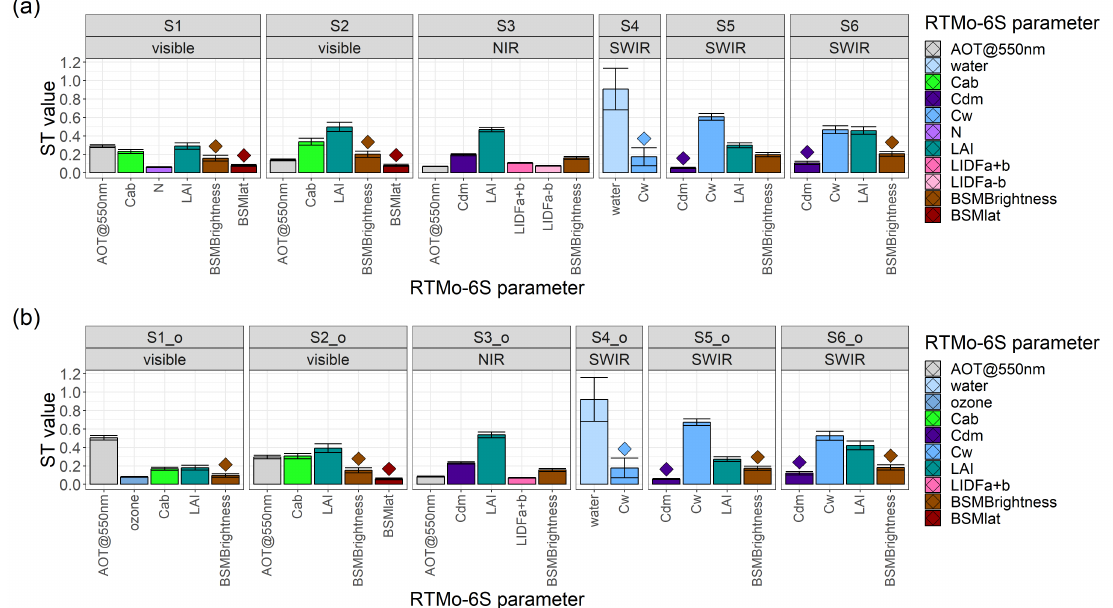
Figure 6. Significant total order sensitivity indices (ST > 0.05) for SLSTR instrument. Parameters marked with diamonds had insignificant first order sensitivity index (S1 < 0.05) and reached significant ST through interactions. ( a )—nadir view, ( b )—oblique view. Definitions of parameters can be found in